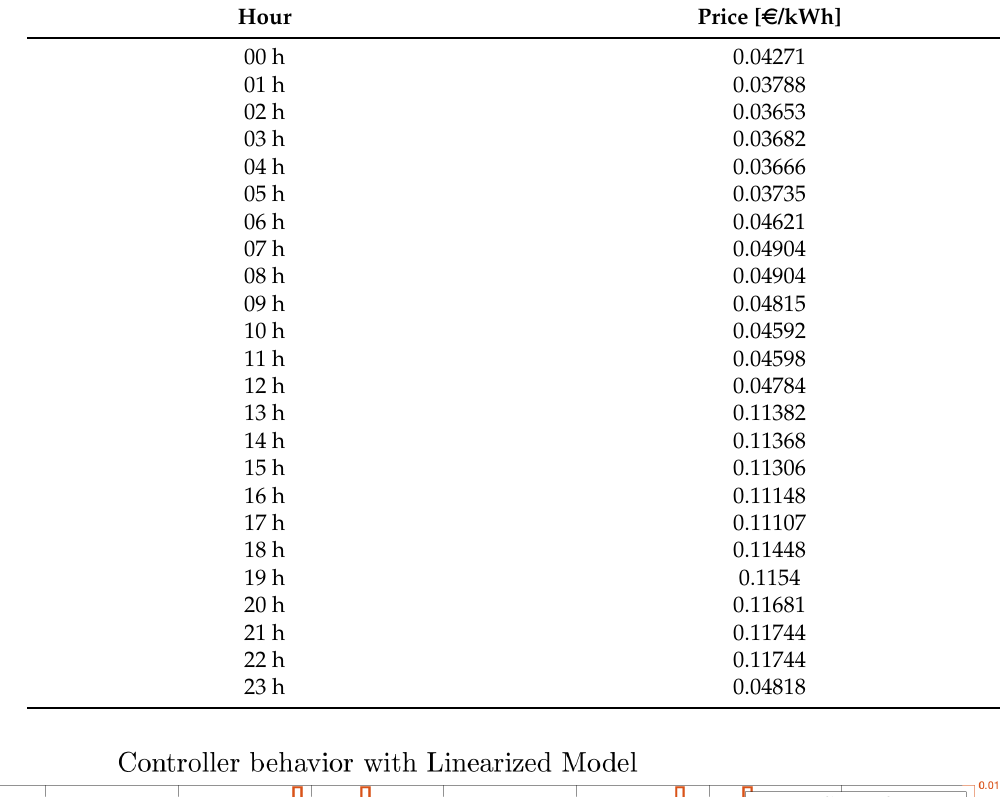
Table 1. Electricity tariff per hour in Spain (not including fixed energy term or electricity bill taxes).